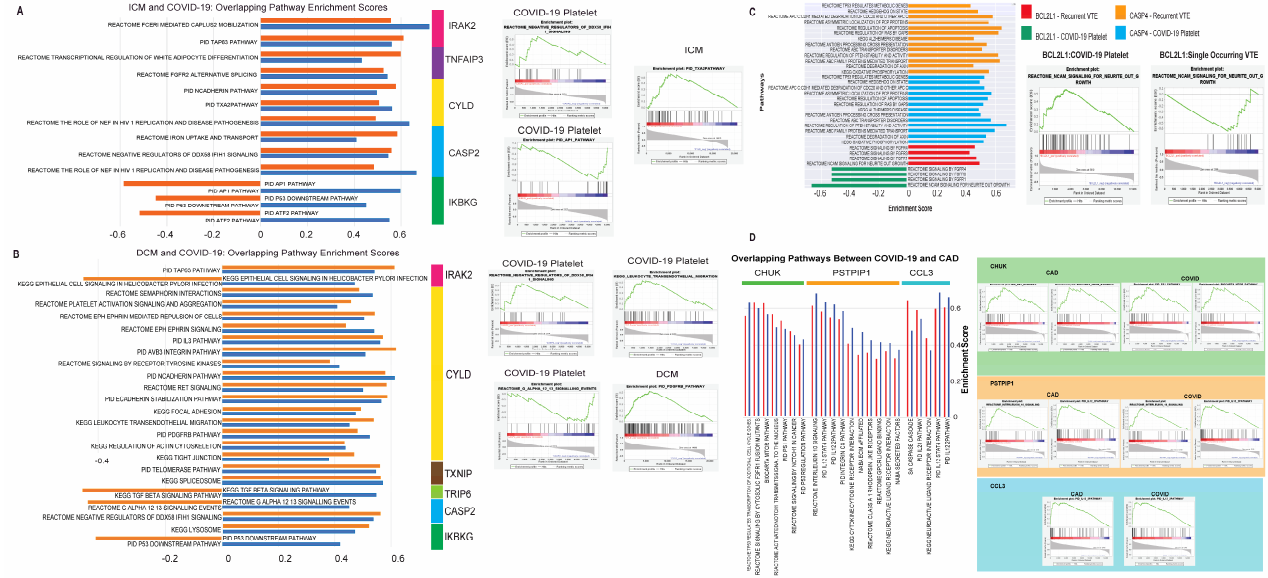
Figure A2. ( A ) Bar plots showing direction of correlation between genes and canonical pathways for genes dysregulated in both ischemic cardiomyopathy (ICM) and COVID-19 patients. ( B ) Bar plots showing direction of correlation between